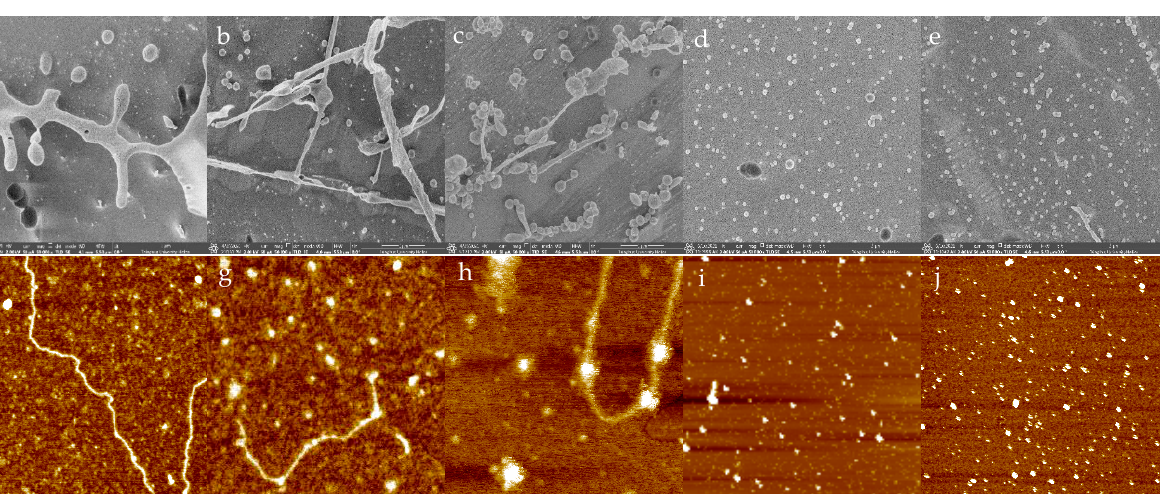
Figure 6. Cryo-SEM and AFM graphs of WSG and its conjugates: ( a ) Cryo-SEM graph of WSG; ( b ) Cryo-SEM graph of WSG-PPI conjugates; ( c ) Cryo-SEM graph of WSG-SPI conjugates; ( d ) Cryo- SEM graph of PPI; ( e ) Cryo-SEM graph of SPI; ( f ) AFM graph of WSG; ( g ) AFM graph of WSG-PPI conjugates; ( h ) AFM graph of WSG-SPI conjugates; ( i ) AFM graph of PPI; ( j ) AFM graph of SPI.